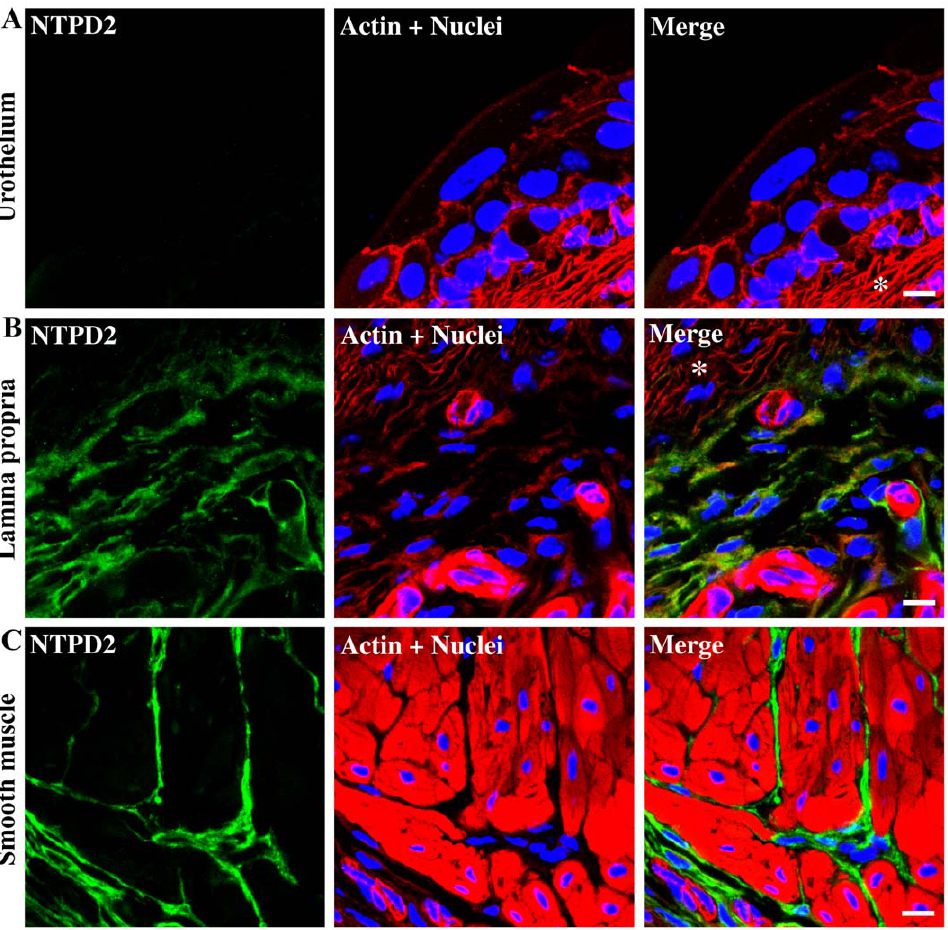
Figure 4. Immunolocalization of NTPD2 in different regions of the bladder. Cryosections of mouse bladders were labeled with antibodies to NTPD2 (green), rhodamine phalloidin to label the actin cytoskeleton (red) and Topro-3 to label nuclei (blue). Color merged panels are shown on the right. A) NTPD2 staining at the level of the urothelium, B) NTPD2 staining at the level of the lamina propria; white asterisks (*) indicate areas positive for actin but negative for NTPD2 in the lamina propria. C) NTPD2 staining at the level of the detrusor smooth muscle. White scale bars =10 m m.